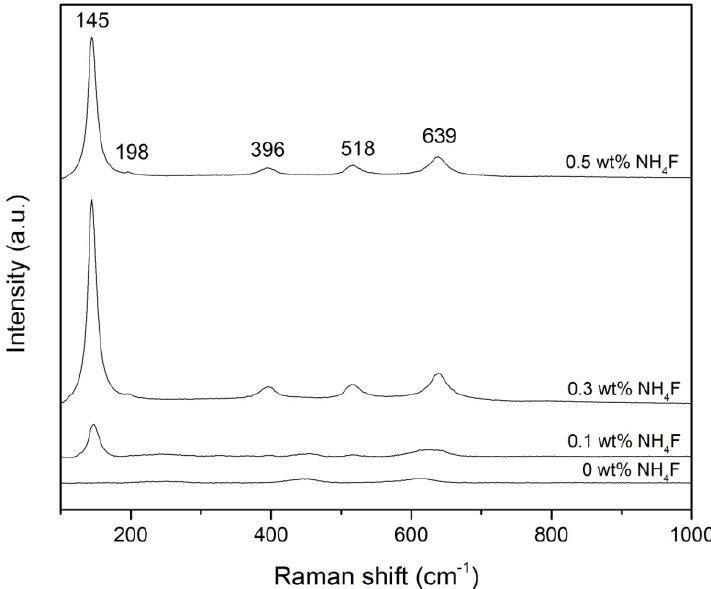
Figure 4. Raman spectrum of WO 3 -loaded TiO 2 produced with different fluoride ion